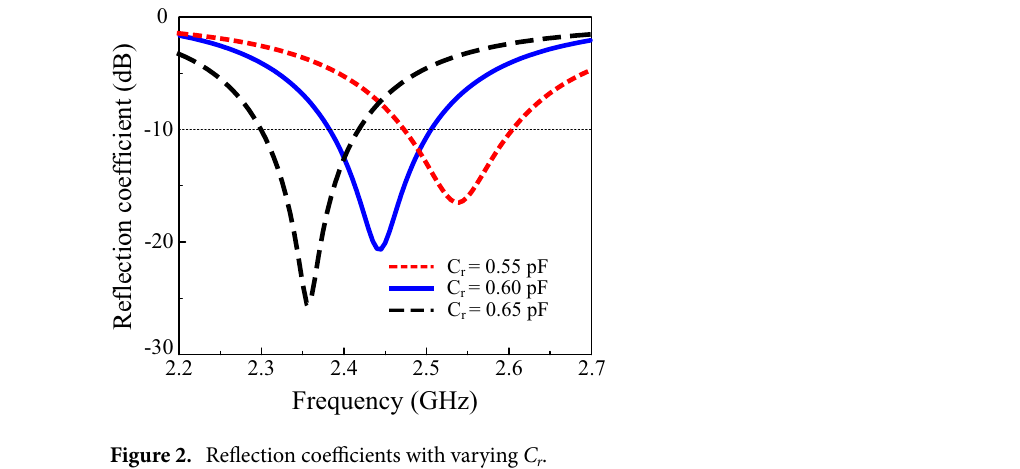
Figure 2. Reflection coefficients with varying C r .